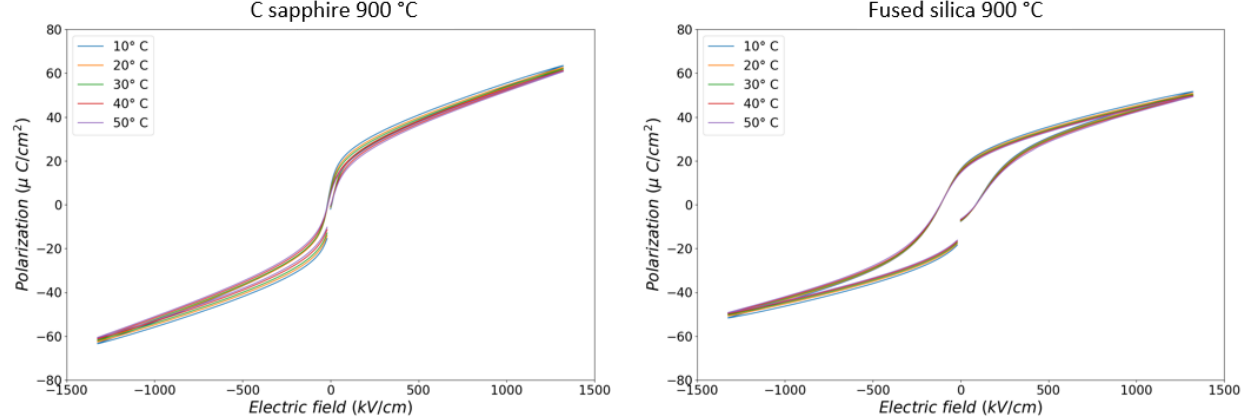
Figure 4. Polarisation vs. electric field loops for PST films.